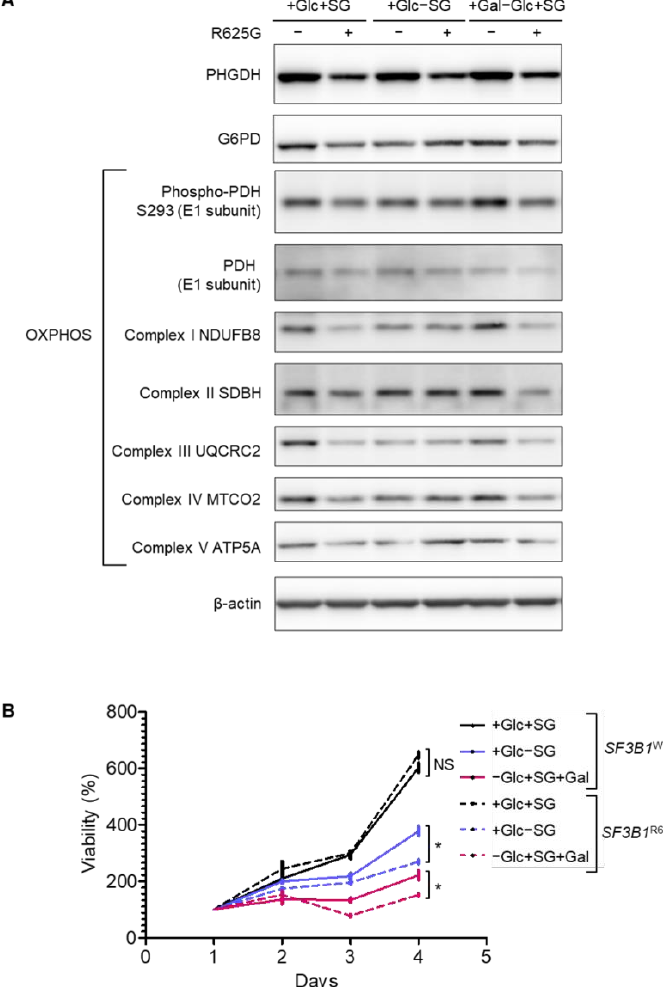
Figure 3. SF3B1 R625G leads to a decreased expression of metabolic proteins and sensitizes cells to serine, glycine and glucose deprivation. ( A ) Expression of metabolic targets involved in serine de novo synthesis, PPP (pentose phosphate pathway), glycolysis and OXPHOS (oxidative phosphorylation) upon 3 days of media deprivation in SF3B1 WT and SF3B1 R625G isogenic Mel202 cells by Western blot. β -actin was immunoblotted as a control for protein quantity. ( B ) Cell viability of SF3B1 WT and SF3B1 R625G Mel202 cells upon media starvation (Gal: galactose, Glc: glucose, and SG: serine and glycine). The complete media condition was also included (+Glc+SG). Data are represented as the mean of triplicates ± SD. The Mann–Whitney U test was used to generate the p -values; * p < 0.05; NS: